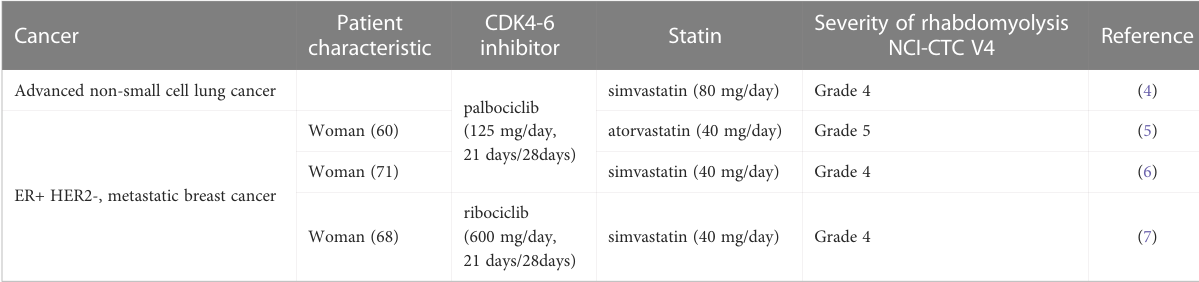
TABLE 1 Reported toxic myositis in patients treated with cyclin-dependent inhibitors.